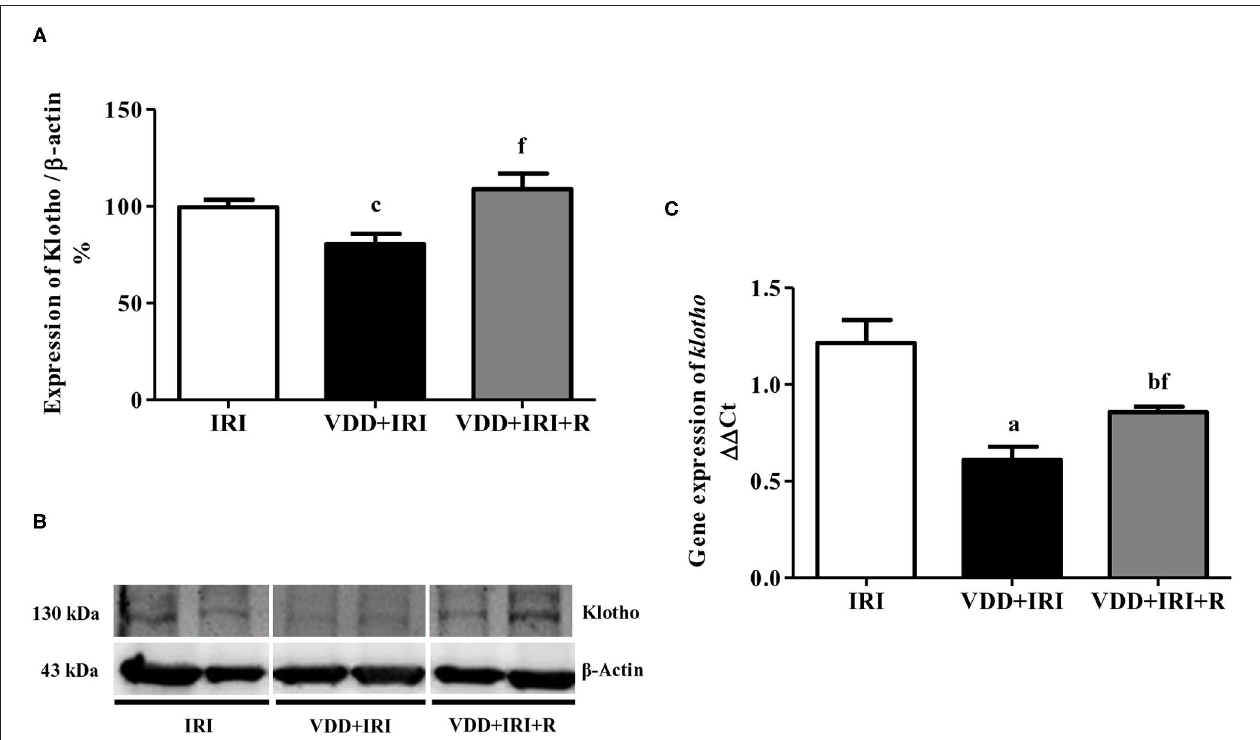
FIGURE 1 | Semiquantitative immunoblotting and real-time quantitative polymerase chain reaction for renal Klotho expression evaluated 90 days after ischemia/reperfusion insult (IRI) on day 30. (A) Densitometric analysis of samples from IRI, VDD + IRI and VDD + IRI + R rats. (B) Representative immunoblots which reacted with anti-Klotho revealing a 130 kDa band. Note that vitamin D replacement restored the expression of Klotho protein in the VDD + IRI + R rats. (C) Bar graph of klotho gene expression values. Data are mean ± SEM. a p < 0.001, b p < 0.01, c p < 0.05 vs. IRI; f p < 0.05 vs. VDD + IRI. VDD, vitamin D deficiency; R, vitamin